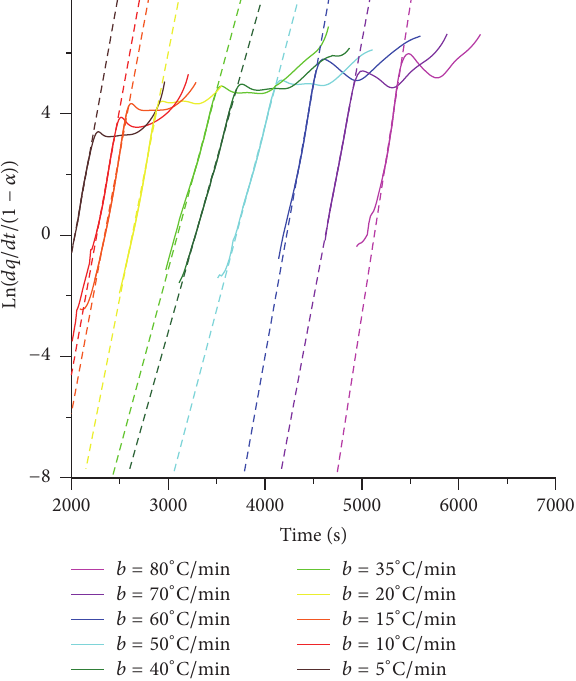
Figure 6: Dependence of natural logarithm of oxidation reaction rate on time for